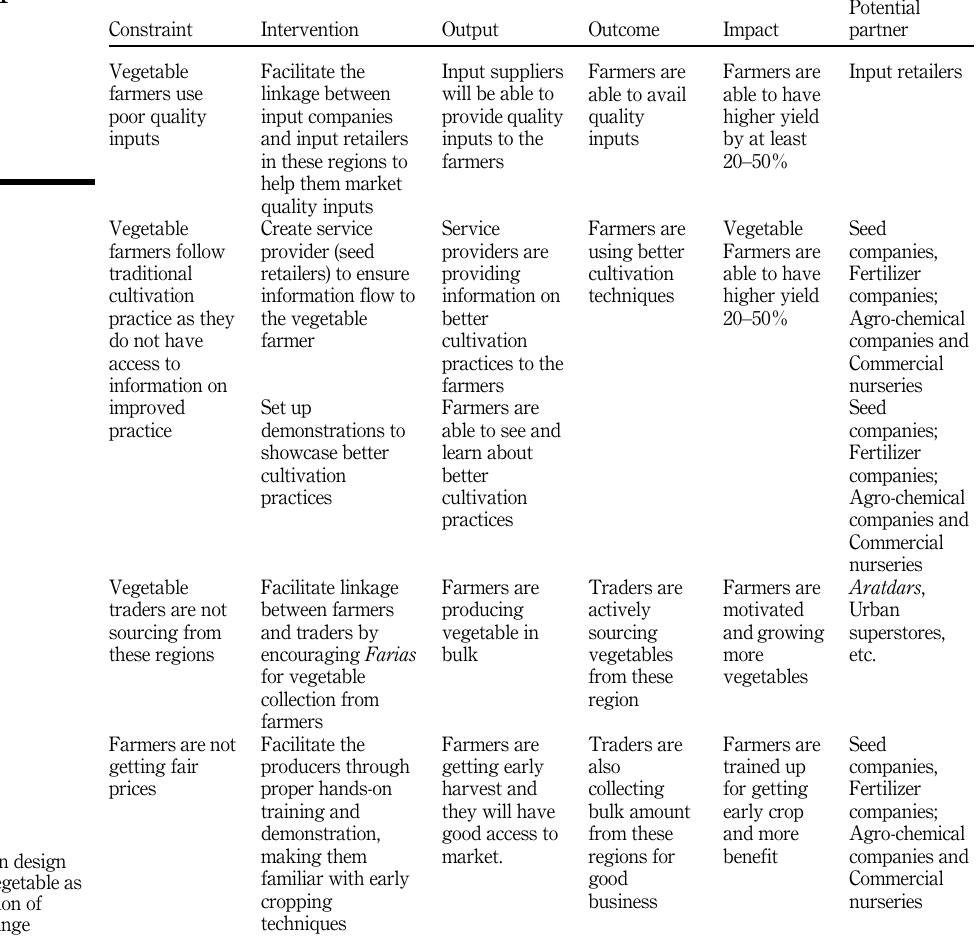
Table 11. Intervention design table for vegetable as an adaptation of climate